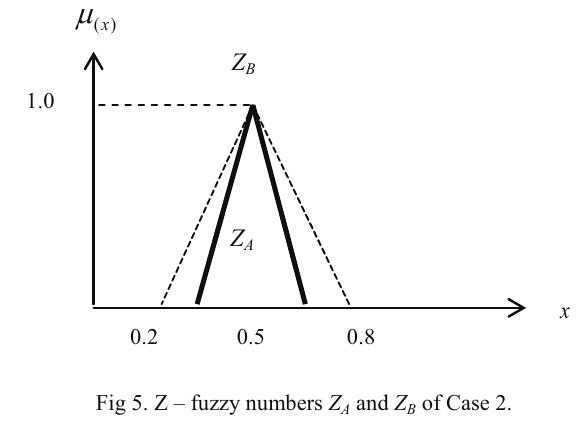
Fig 5. Z – fuzzy numbers Z A and Z B of Case 2.